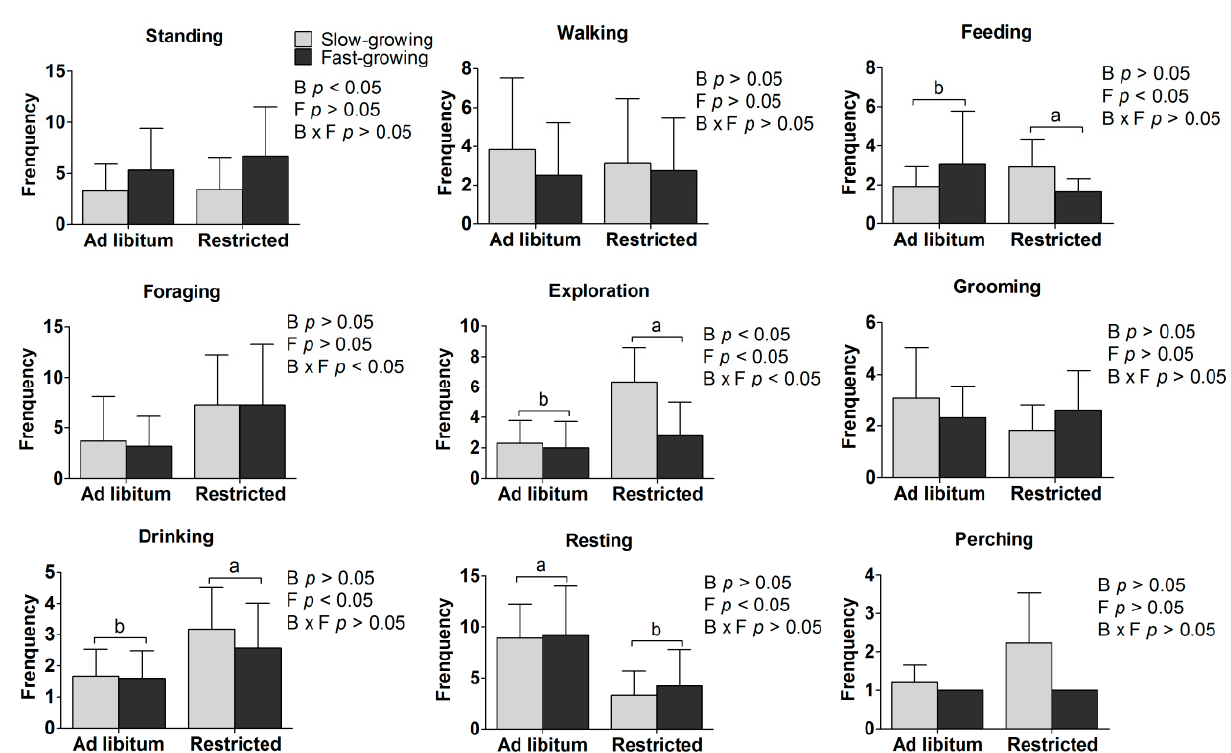
Figure 2. Effects of feed restriction on in situ behavior of slow- and fast-growing chickens. a, b represent the significant difference between the ad libitum and feed restricted treatments ( p < 0.05). B: breed, F: feeding method, B × F: interaction between breed and feeding method.